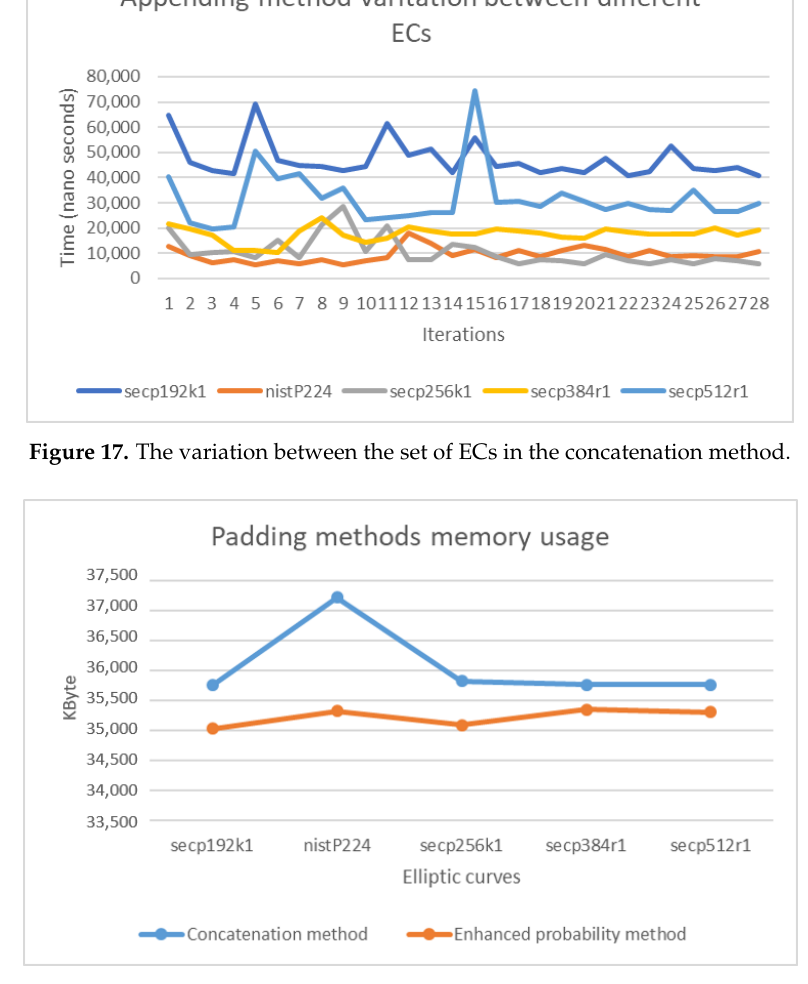
Figure 18. The Memory usage on padding methods using the set of